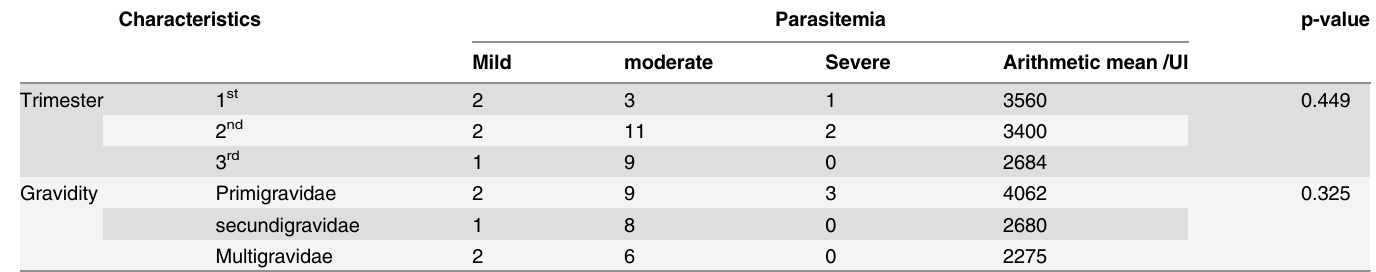
Table 3. Degree of parasitemia with regard to Trimester and gravidity among pregnant women in the rural surroundings of Arbaminch Town, South Ethiopia between April and June 2013.